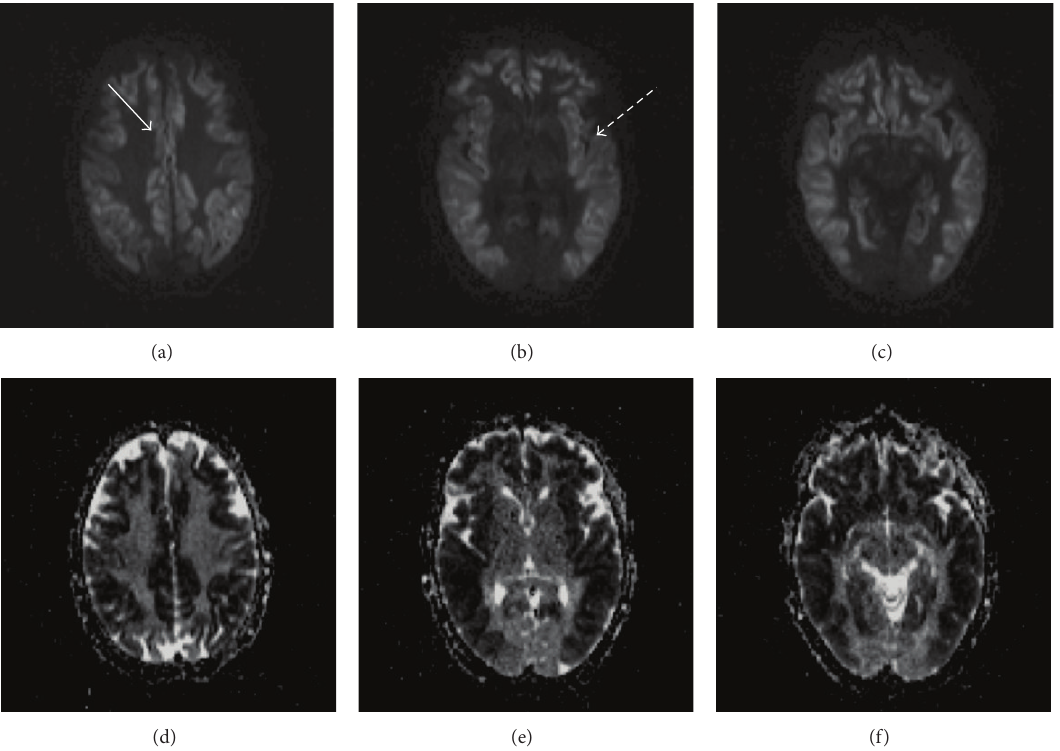
Figure 1: MRI of the brain six hours after the onset of SE. ((a), (b), and (c)) Axial diffusion tensor images (DTI) with extensive hyperintense cortical diffusion restriction, with the characteristic involvement of the cingulate gyrus (solid arrow) and insular cortex (spotted arrow) seen in HE; ((d), (e), and (f)) Axial apparent diffusion coefficient (ADC) images with corresponding hypointensity, characteristic of cytotoxic edema. The images are significant for the absence of diffusion restriction in the basal ganglia, thalamus, and relative sparing of the occipital